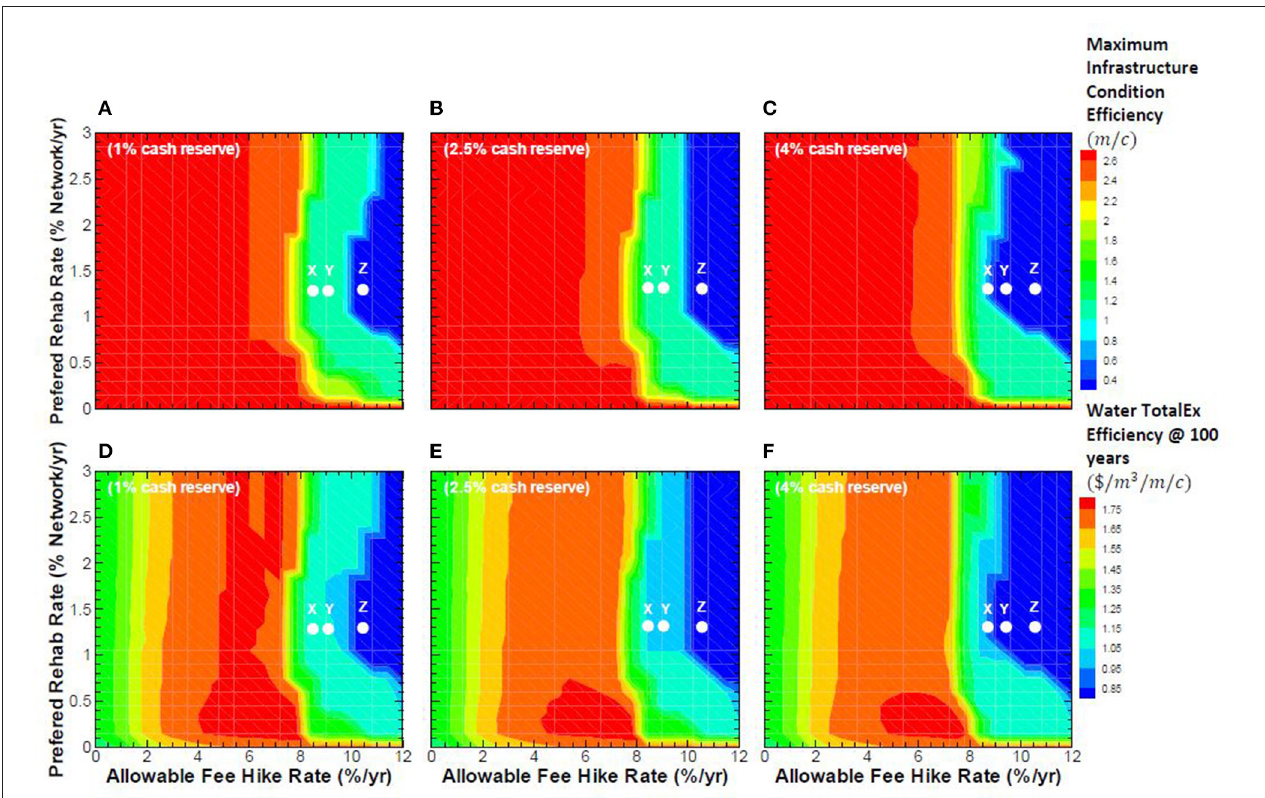
FIGURE 9 | (A–F) Impact of allowable fee-hike and preferred rehabilitation rates on infrastructure condition efficiency and water TotalEx efficiency.